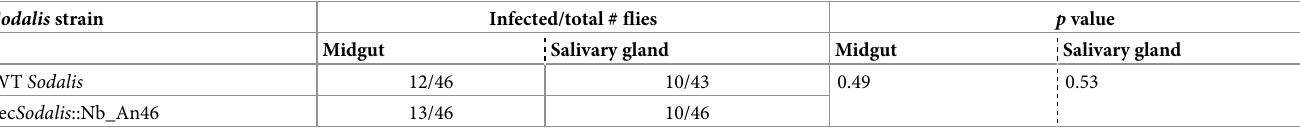
Table 1. Microscopic examination of the proportion of male G . m . morsitans flies infected with T . b . brucei . Flies were harboring WT S . glossinidius or rec Sodalis :: Nb_An46 that expresses the Nb_An46. Differences in infection rates between WT S . glossinidius and rec Sodalis ::Nb_An46 harboring flies were compared using Chi- square (two-sided) and considered significant if p-values were lower than